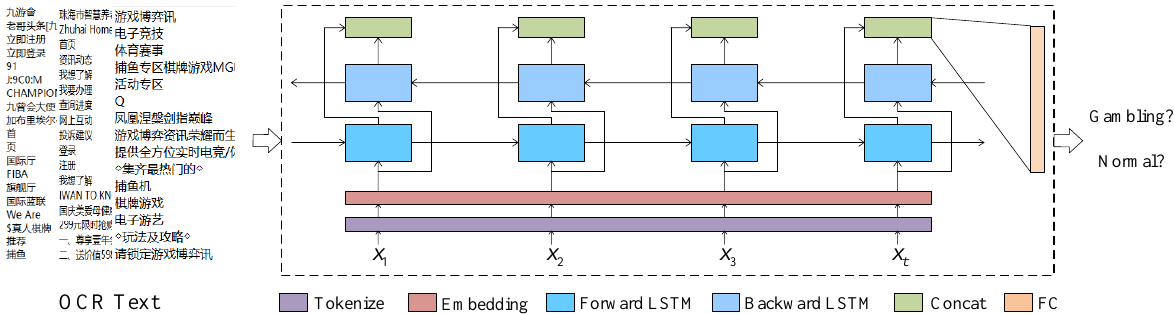
Figure 5. The structure of the text